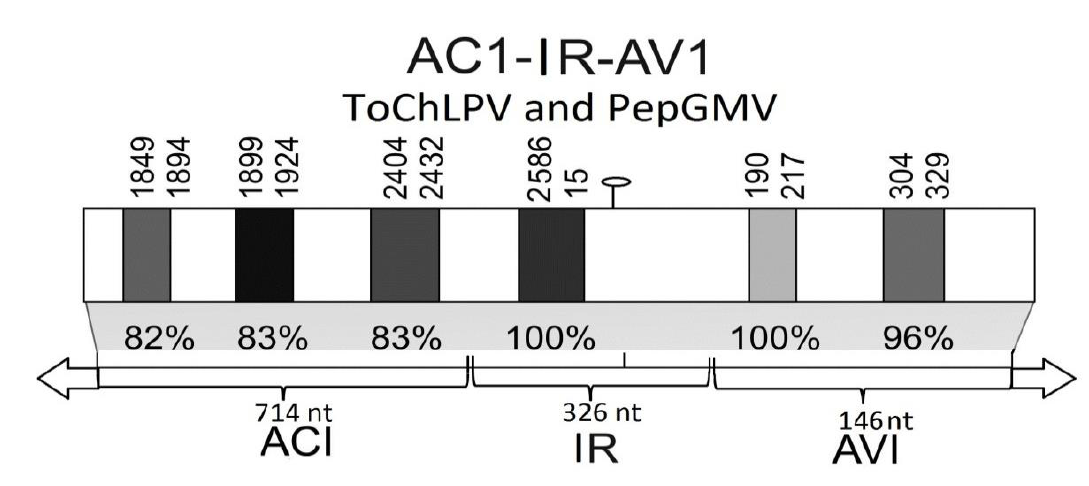
Figure 3 . Alignment of region AC1-CR-AV1 from ToChLPV and PepGMV . The six regions highlighted in the gray boxes indicate fragments longer than 22 nts of both viruses, which show homology from 82% to